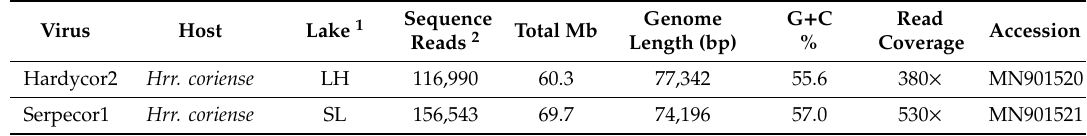
Table 1. Sequencing details for viruses Hardycor2 and Serpecor1.